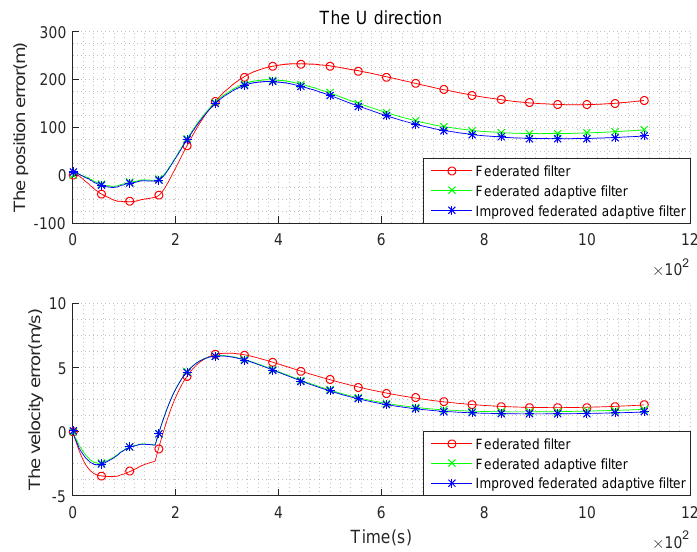
Figure 15. Comparison of the navigation error with time-varying state noise and biased estimation in U direction.